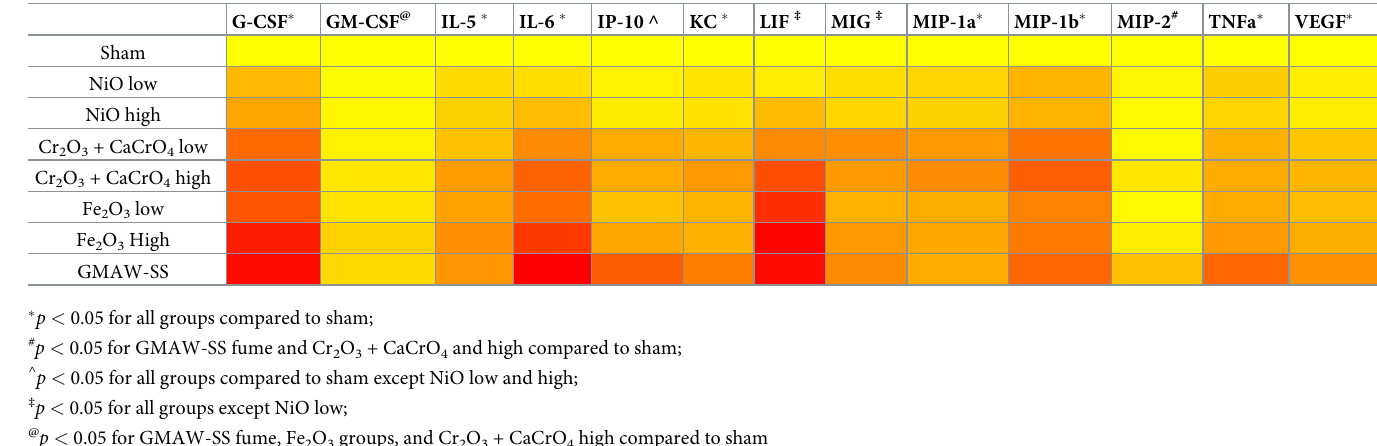
groups, respectively (S3 Table). Fewer changes in lung and liver relative mRNA levels were detected in NiO or Cr O + CaCrO groups compared to the GMAW-SS fume- and Fe 2 3 4 -exposed groups (S3 Table). No changes in relative mRNA levels occurred in NiO low- or high-dose groups in any of the genes examined. At 1 day post-exposure to Cr low- and high-dose, levels of liver Mt1 and Saa1 were significantly increased above sham (~5- and ~12-fold for low-dose and ~8- and ~17-fold for high-dose Mt1 and Saa1 levels, respec- tively; p < 0.05; S3 Table). At 7 days, Mt1 and Saa1 levels were still significantly increased ~ 2 O + CaCrO high-dose exposed group (S3 Table; p < 0.05). Among relative fold in the Cr 2 3 4 lung mRNA levels, only Hmox1 levels were significantly increased in Cr dose animals compared to sham (~2-fold; p < 0.05; S3 Table).